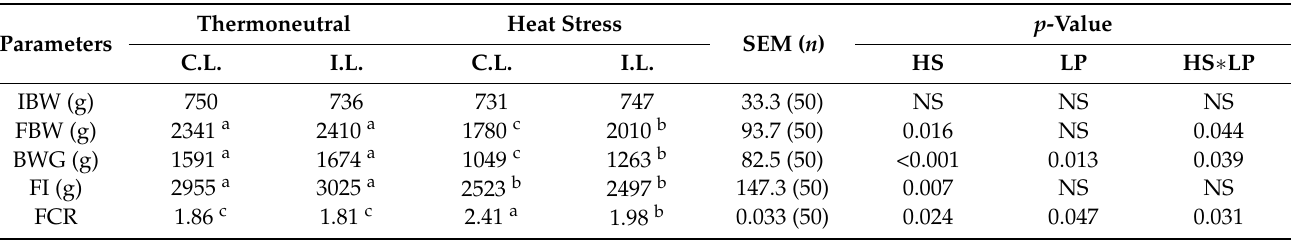
Table 2. Effect of heat stress (HS), light program (LP), and their interaction (HS ∗ LP) on growth performance of broiler